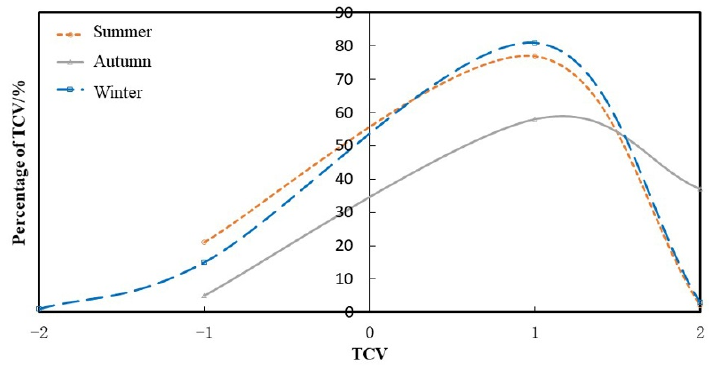
Figure 4. The percentage of TCV in the summer, autumn, and winter.